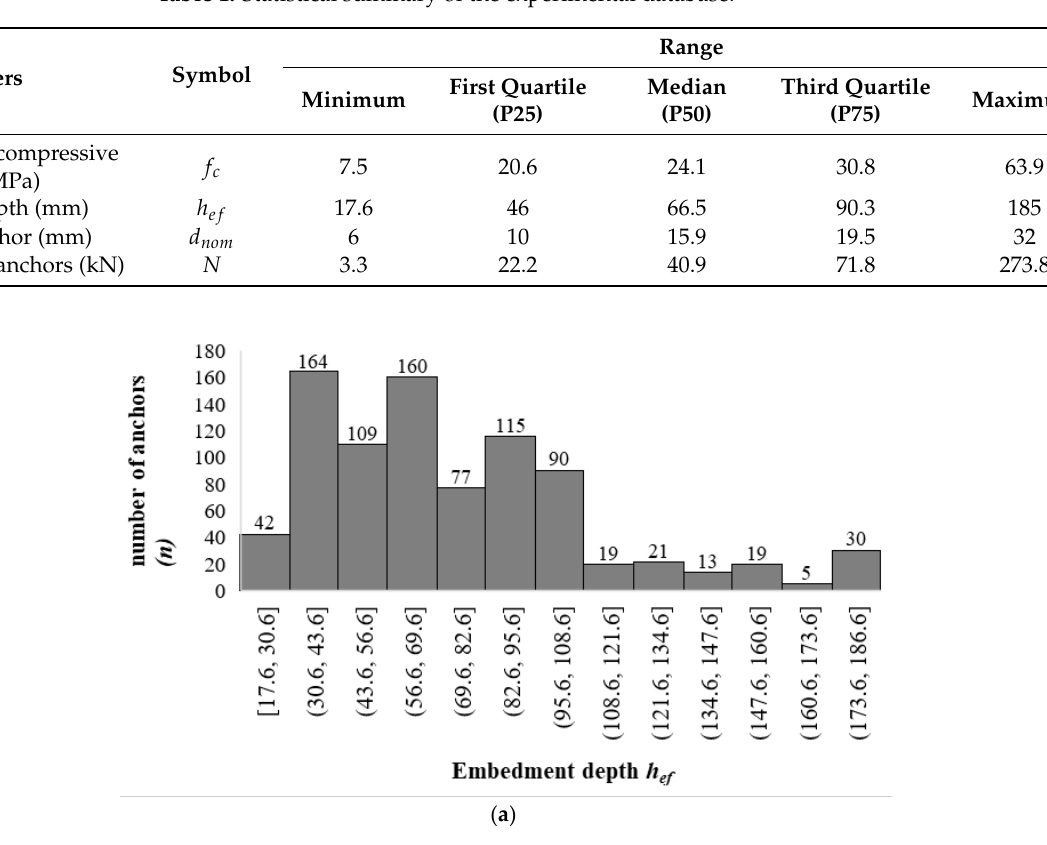
Figure 2. Sketch of concrete edge breakout for an anchor under shear with a load toward the edge and dimensions of idealised failure body.